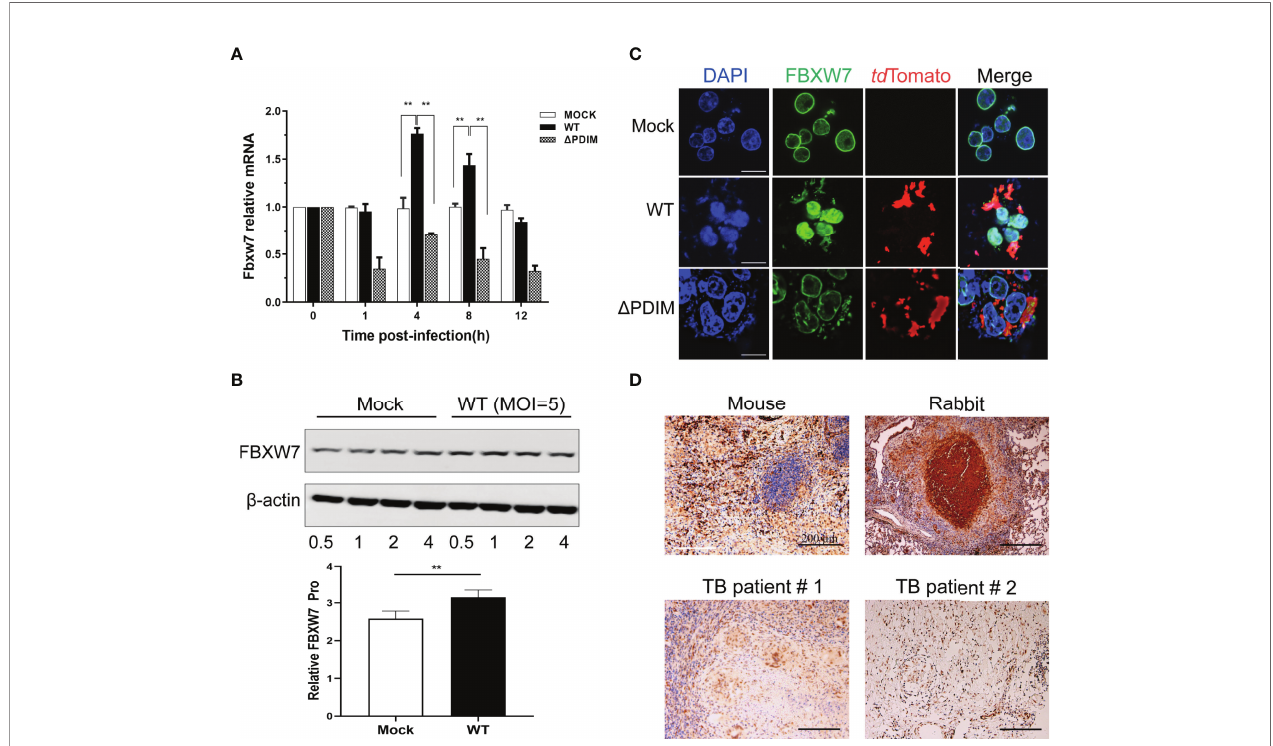
FIGURE 2 | FBXW7 is differently expressed in macrophages after WT Mm infection and in the lung tissues of hosts with Mtb infection. (A) mRNA expression of FBXW7 in macrophages after Mm infection (MOI of 5) over 12 hours (n=3) was detected by q RT-PCR. Increased expression of FBXW7 mRNA was observed at 4 and 8 h in cells post infection with WT Mm relative to MOCK ( P < 0.01). (B) protein expression of FBXW7 in macrophages after WT Mm infection (MOI of 5) over 0.5 to 4 h relative to ß-actin. ** P < 0.01 (C) Representative images of macrophages stained for FBXW7 (green) and the Mm marker td Tomato (red). Nuclei were counterstained with DAPI to identify the cellular location of FBXW7. Scale bar, 10 m m. (D) Representative immunohistochemical images of FBXW7 (brown precipitate) in the granulomas of lung samples from experimentally Mtb -infected C57BL/6J mouse and NZW rabbit and two natural Mtb-infected patients. Nuclei are counterstained with hematoxylin. Scale bar, 200 m m. The experiments were performed three times with similar